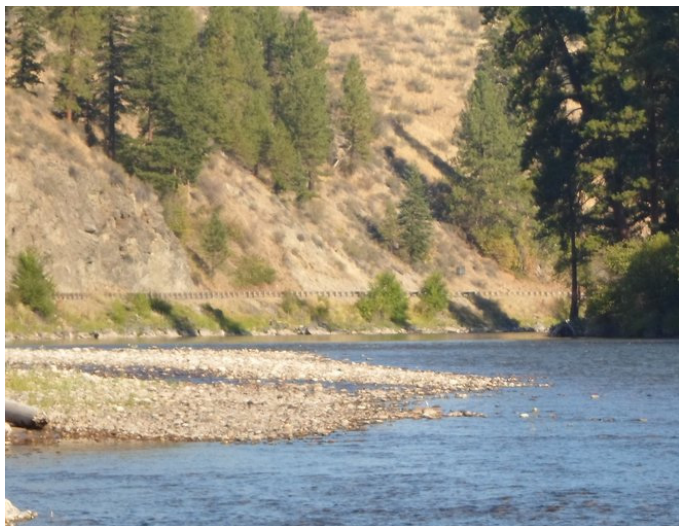
Figure 7. Location of the levee (arrow in both frames) that presently blocks the reoccupation of an extensive side-channel network. Numbers along the channel are river miles; flow is from the upper left to the bottom of the images. Left panel: air photo view (from Google Earth). Right panel: colors show ground elevation relative to the adjacent low-water surface elevation using a LiDAR-generated digital elevation model: deep blue = <0.3 m, turquoise/green = 0.3–2 m, yellow = 2–3 m, tan/brown = 3–4 m, gray >4 m.